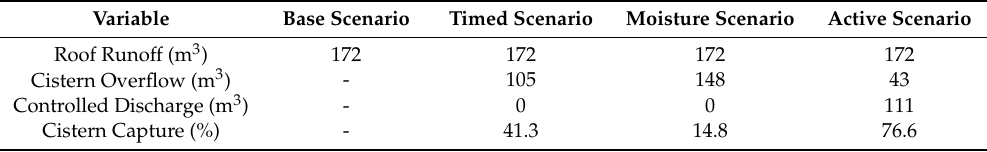
Table 4. Cistern Wet-Weather Performance Comparison (2004–2013)—Annual Averages. Variable Base